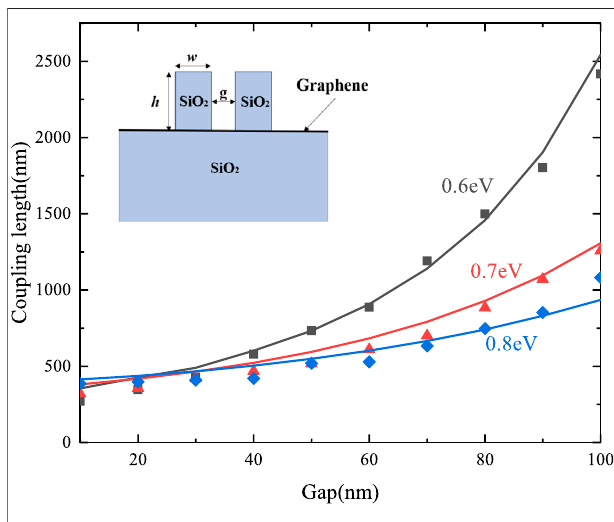
FIGURE 3 | Coupling lengths of two parallel waveguides vary with the gap distance, when the chemical potential is 0.6e V (gray), 0.7 eV (red), and 0.8 eV